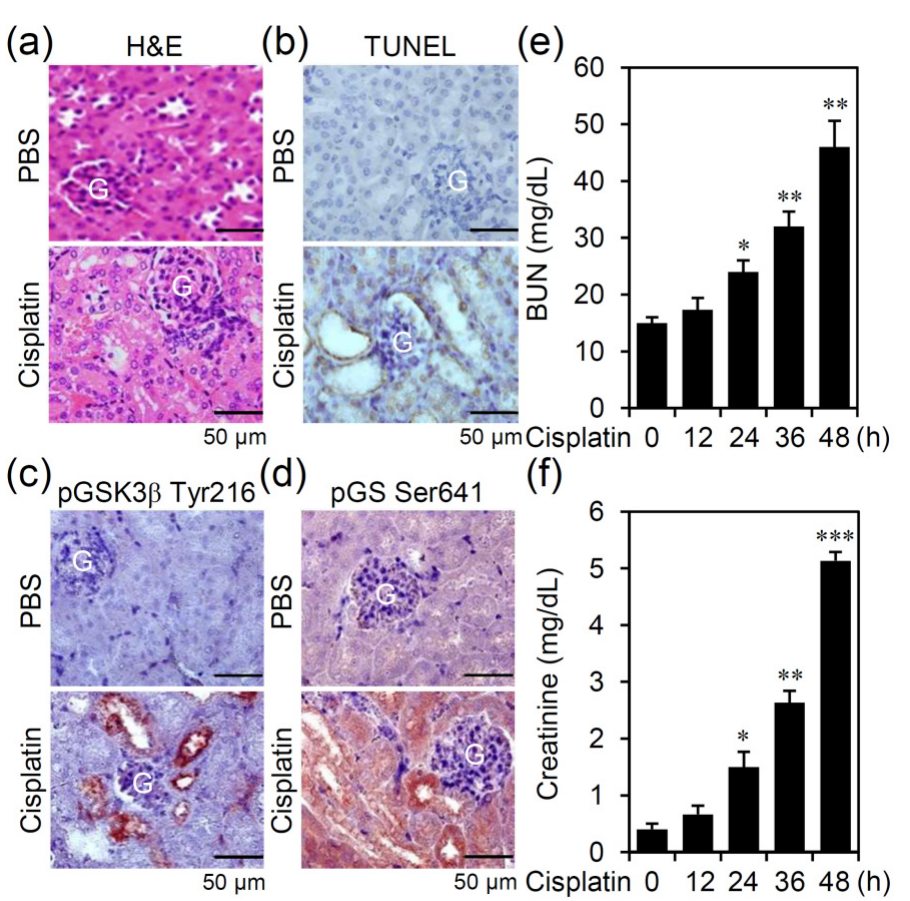
Figure 1. Cisplatin treatment causes GSK-3 β activation in vivo accompanied by nephrotoxicity and tubular cell apoptosis. Male C57BL/6 mice ( n = 3) were injected i.p. with cisplatin (30 mg/kg) for 24 h. ( a ) H&E staining showing histopathological changes. ( b ) TUNEL assay of apoptotic cells ( brown ). Hematoxylin plus AEC-based immunohistochemical staining showed the expression of phospho-GSK-3 β (pGSK-3 β ) Tyr216 ( c , red ) and phospho-GS (pGS) Ser641 ( d , red ). For all of the images (scale bar = 50 µ m), one representative set of data obtained from three mice is shown. G, glomeruli. Serum levels of ( e ) BUN and ( f ) creatinine were determined after cisplatin stimulation in a time-dependent manner. * p < 0.05, ** p < 0.01, and *** p < 0.001 compared with untreated